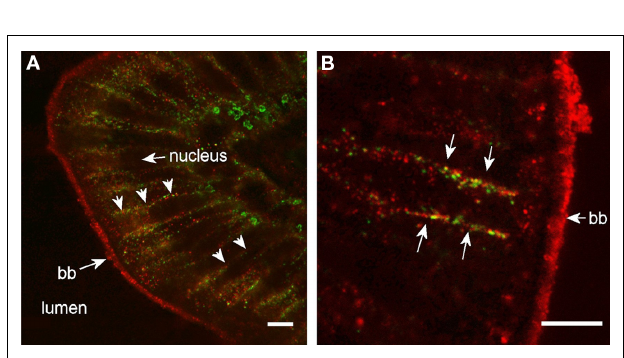
FIGURE 10 | High magnification confocal images (100 × objective) showing localization ofAqp8ab in the posterior segment of intestine from SW-acclimatedAtlantic salmon. Sections were incubated with a cocktail of antibodies against Aqp8ab (red) and Na + , K + -ATPase (green). Lumen, nuclei, brush border (bb), and lateral membranes (arrows) are indicated. Size bar = 20 μ